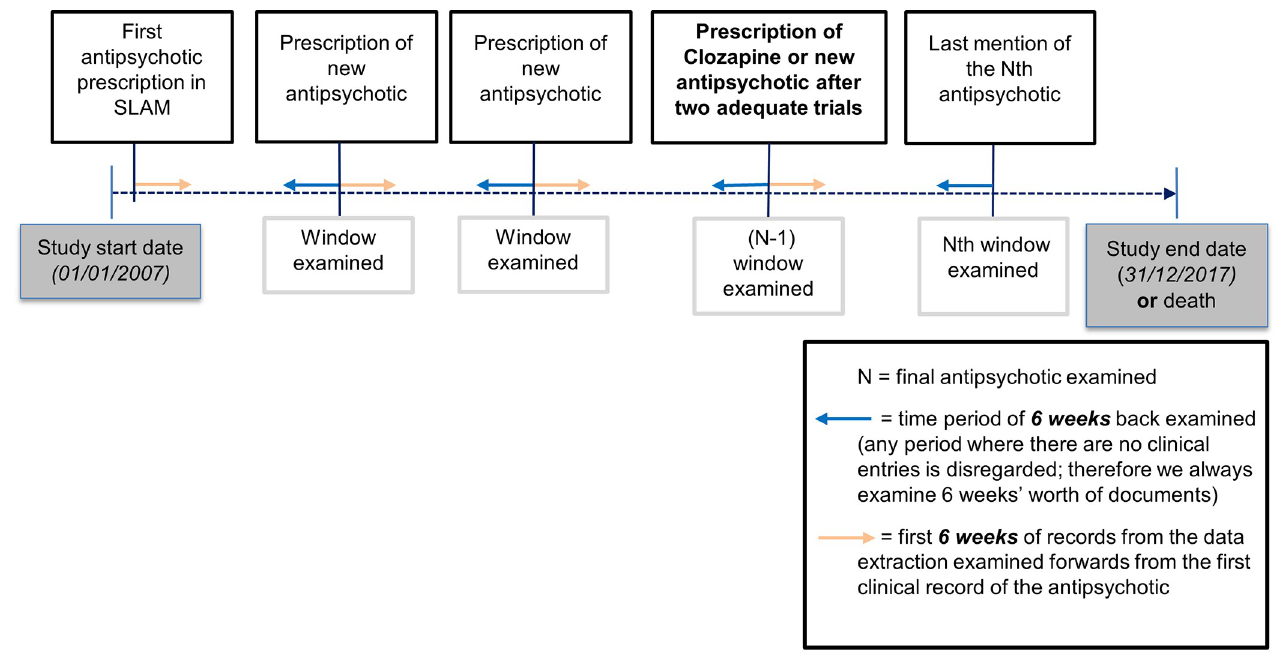
Fig 1. Antipsychotic coding process timeline for coding outcome